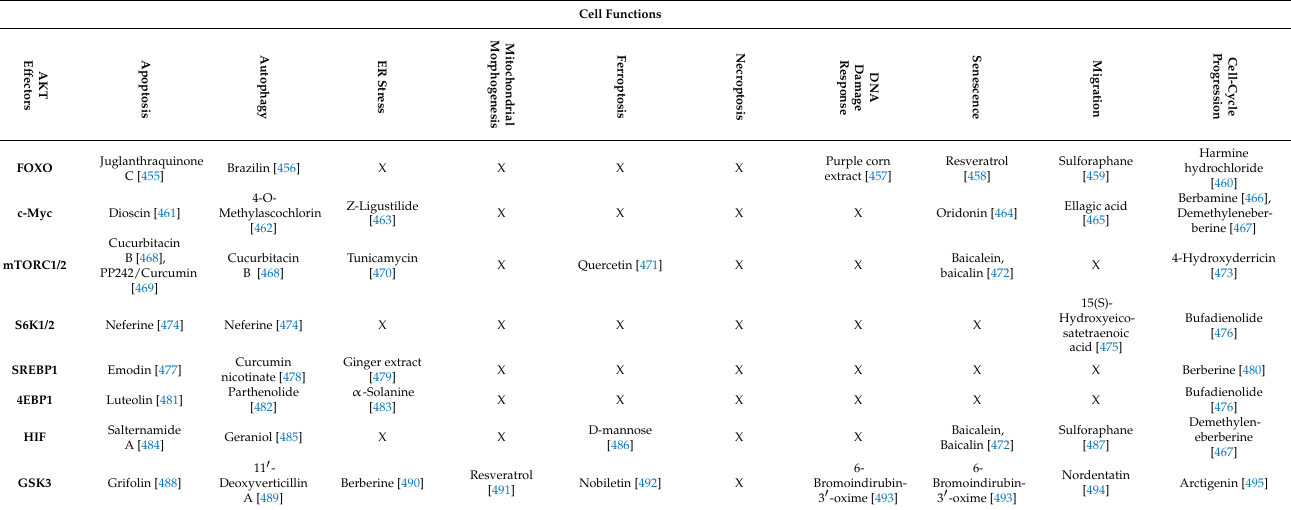
Table 7. Natural products affecting cell functions through AKT effector